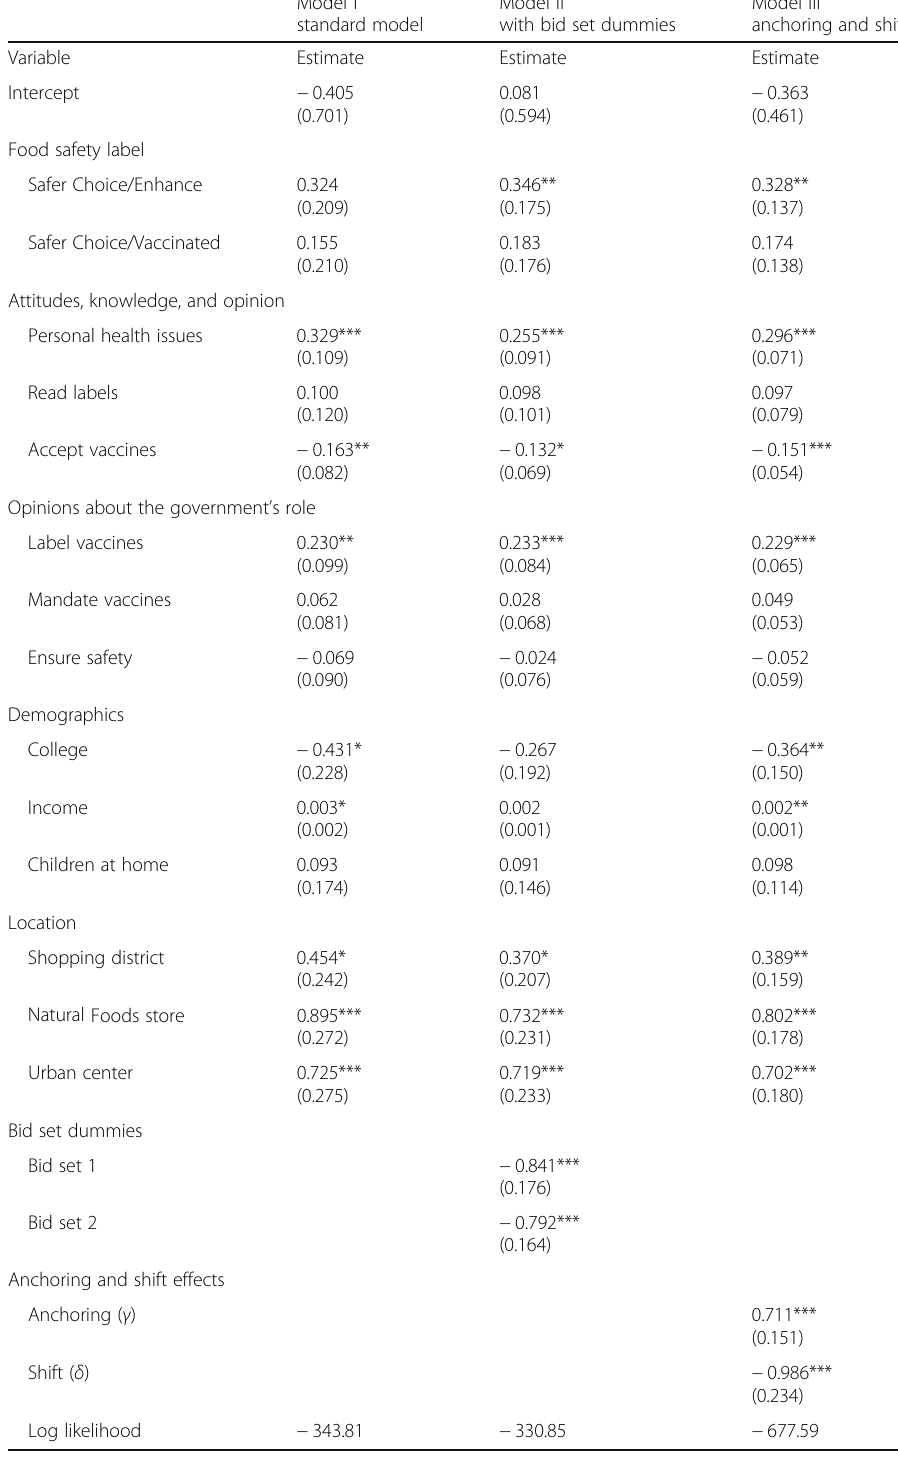
Table 6 Results from double-bounded contingent